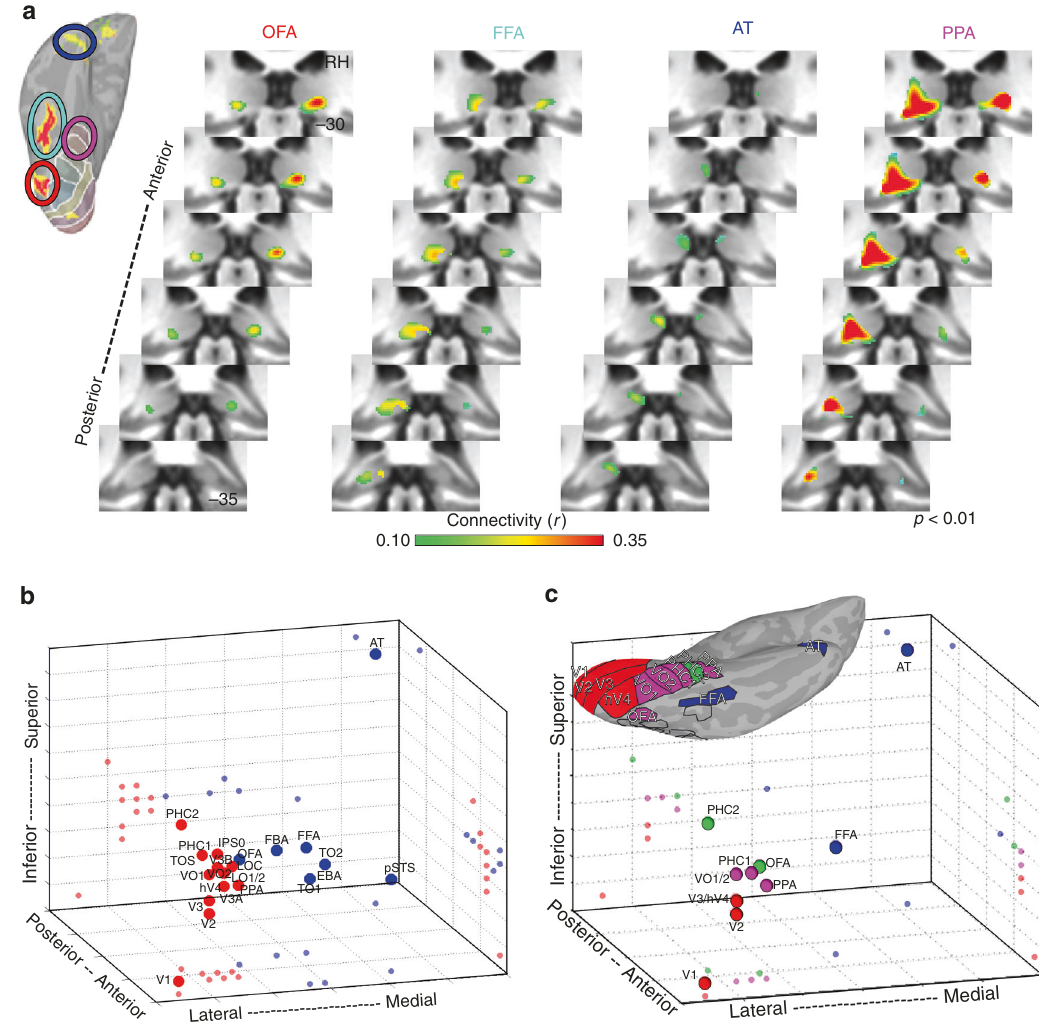
Fig. 6 Functional coupling with ventral pulvinar. a Group average correlation maps ( n = 13; p < 0.01 from one-sample t-test across subjects) are shown for four cortical areas de fi ned based on their functional specialization: occipital face area (orange), fusiform face area (cyan), anterior temporal face area (blue), and parahippocampal place area (magenta). Correlations were strongest within the ventral and posterior-most portions of the pulvinar for each area. Surface fi gure illustrates the localization of face- and scene-selective regions in an individual subject. Circle color code matches area labels on right. Each cortical region showed greater activity for face vs. scene stimuli (p < .01, FDR-corrected). b Three-dimensional plot of the peak occipital and temporal pulvino-cortical connectivity within the ventral pulvinar. Spheres depict the 3D spatial location of each area ’ s peak connectivity within the ventral pulvinar. 2D projections of each data point are plotted on the walls and fl oor of the graph. Clustering revealed 2 groups that differentiated lateral (red) and medial (blue) portions of the ventral pulvinar. c Same plot as in ( b ), but for a subset of ventral areas. Clustering of connectivity within the ventral pulvinar